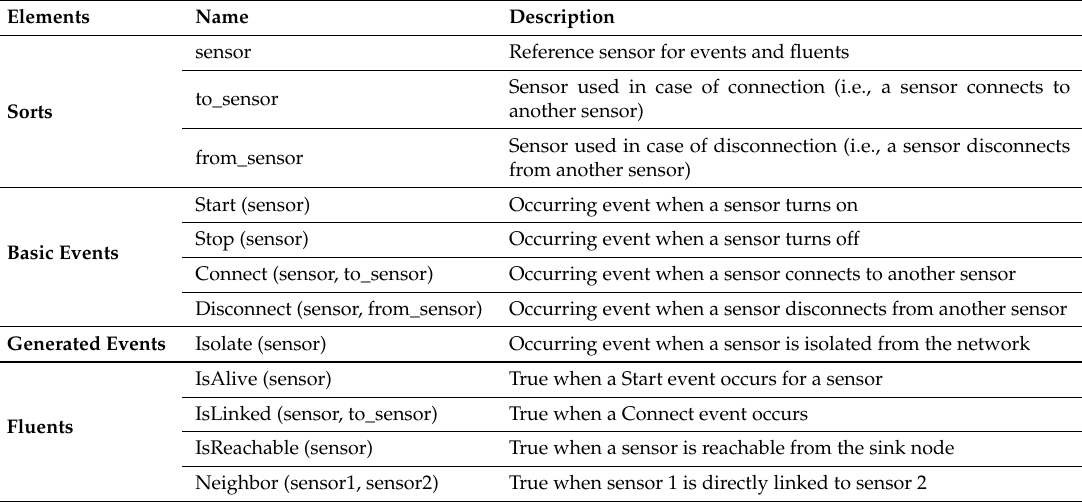
Table 1. Basic elements of the specification for the isolation